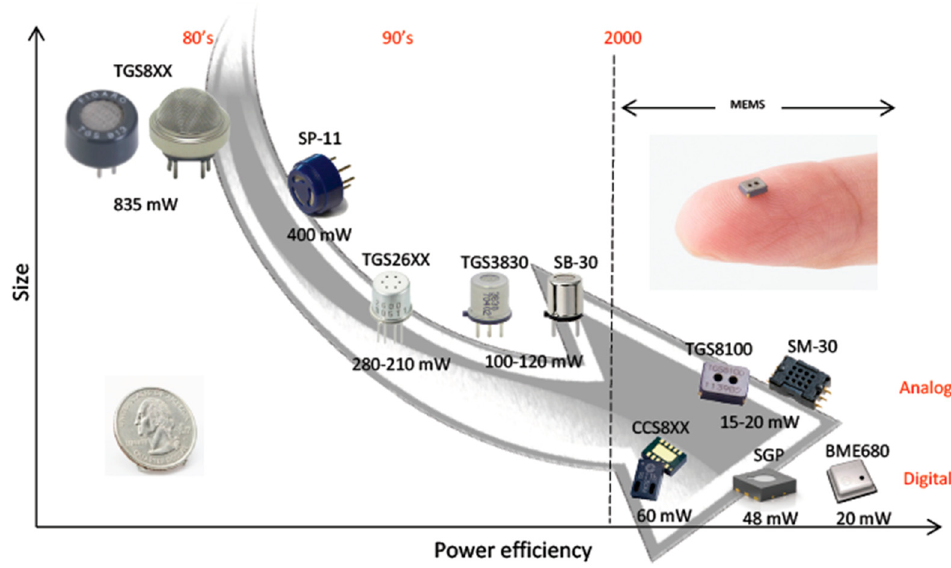
Figure 1. Evolution of metal oxide semiconductor (MOX) technology in terms of size and power efficiency. The background arrow indicates the temporal evolution.